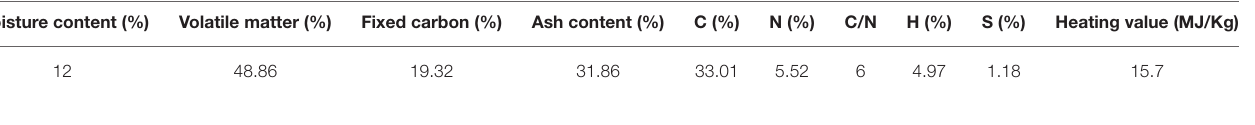
TABLE 3 | Characteristics of sewage sludge in